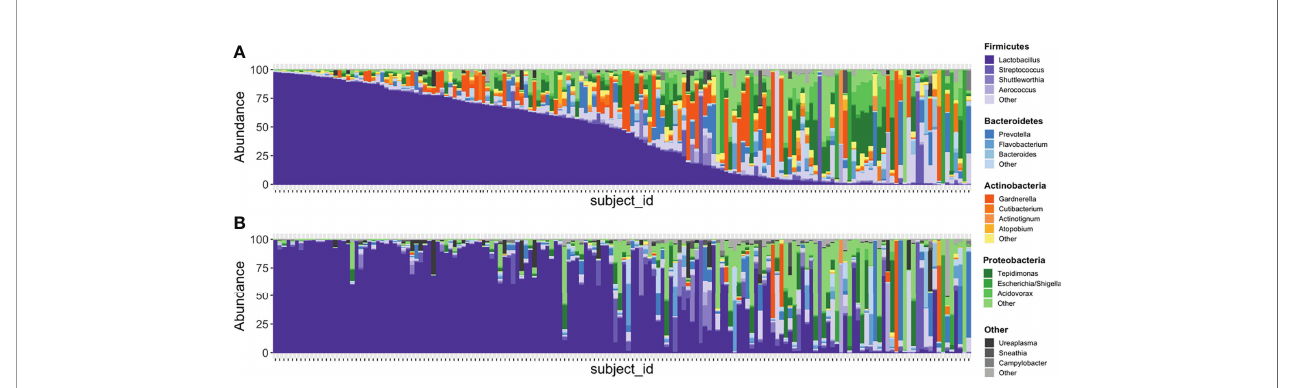
FIGURE 5 | Stacked bar plots illustrating relative abundances of taxa in 167 samples with paired V1-V2 and V4 data. (A) depicts the taxa recovered with the V4 region while (B) depicts the taxa recovered with the V1-V2 region. Each vertical bar depicts an individual sample with plots aligned to compare recovery of data from the same sample in each amplicon. Phyla are assigned distinct colors (e.g., Firmicutes = purple, Bacteroidetes = blue, Actinobacteria = orange, Proteobacteria = green) with individual genera shaded differently. The most intense color shade within each phylum refers to the most abundant genus identi fi ed. Though many genera are recovered in similar abundances between both amplicons, Gardnerella is one that is noticeably different, with substantially more identi fi ed in sequencing data generated from the V4 region.